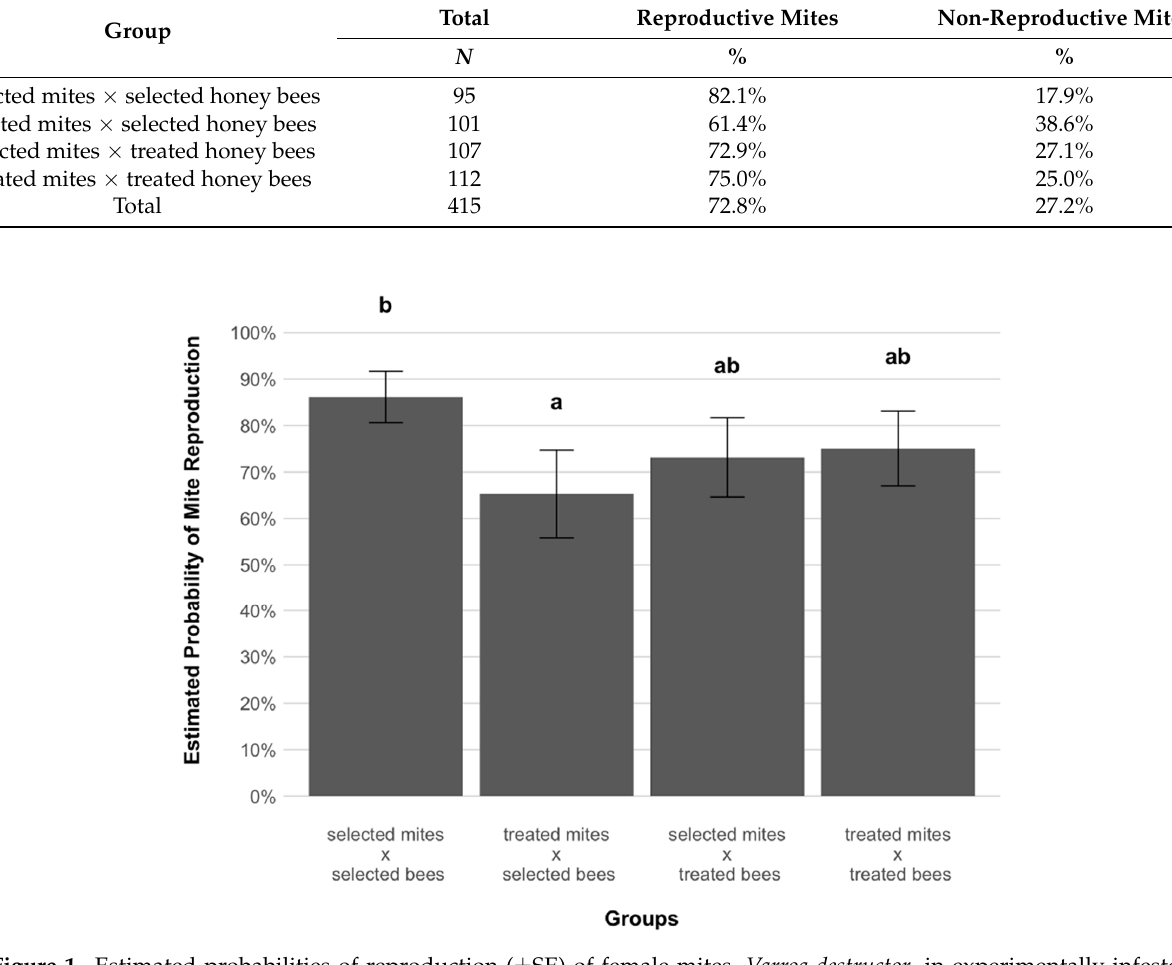
Figure 1. Estimated probabilities of reproduction ( ± SE) of female mites, Varroa destructor , in experimentally infested worker brood cells of the different honey bee, Apis mellifera , host groups (selected-selected, treated-selected, selected-treated, treated-treated). After adjustment for multiple comparison (Tukey method), significant differences were detected between groups as indicated with letters above the bars (GLMM: χ 2 = 9.832, p = 0.02). Both the highest and the lowest reproductive probabilities were detected in mites infesting AWD surviving bees, where selected-associated mites showed a statistically higher reproductive capacity than treated-associated